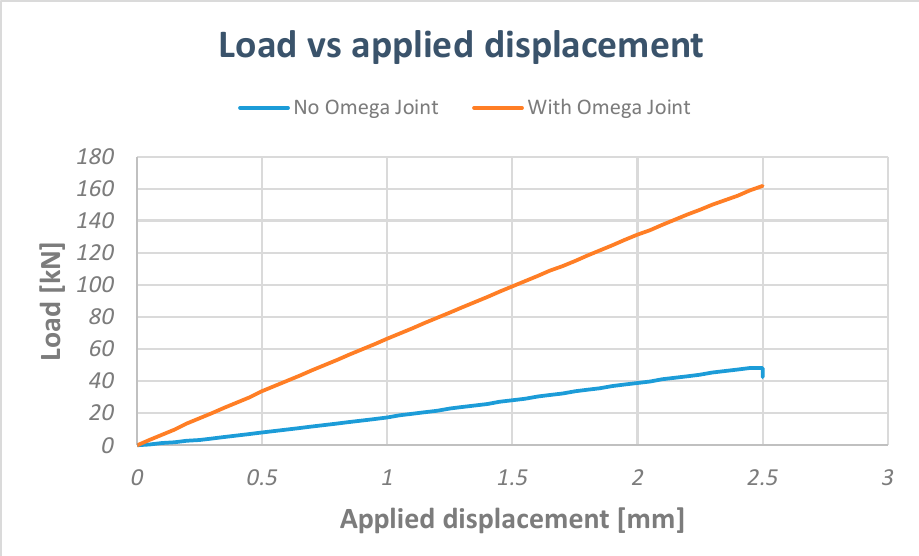
Figure 24. Omega stringer joint (in red).